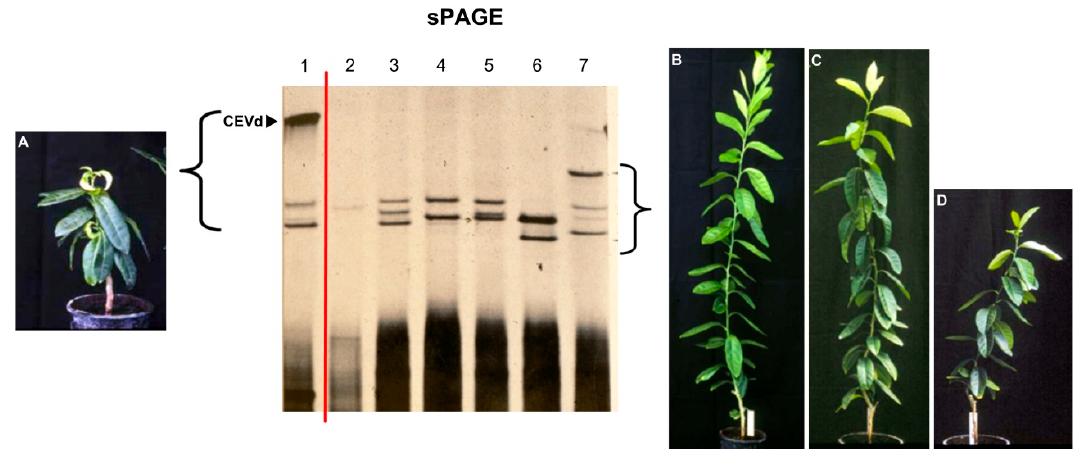
Figure 2. Analysis of inoculated Etrog citron plants by sPAGE and silver staining. Only plants showing severe symptoms ( A ) contained a band with the characteristic mobility of citrus exocortis viroid (CEVd) (1). Analysis of Etrog citron plants displaying mild and moderate symptoms ( B–D ) revealed bands with electrophoretic mobility different from CEVd (2 – 7). Virtually all plants contained a mixture of viroid-like RNAs that had to be further characterized.